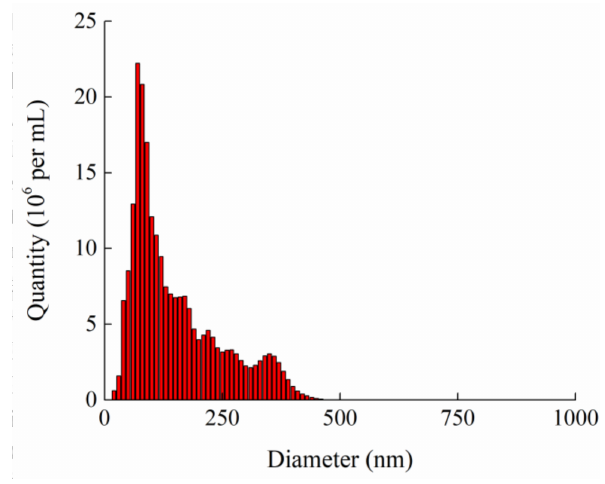
Figure 2. Size distribution of the ozone